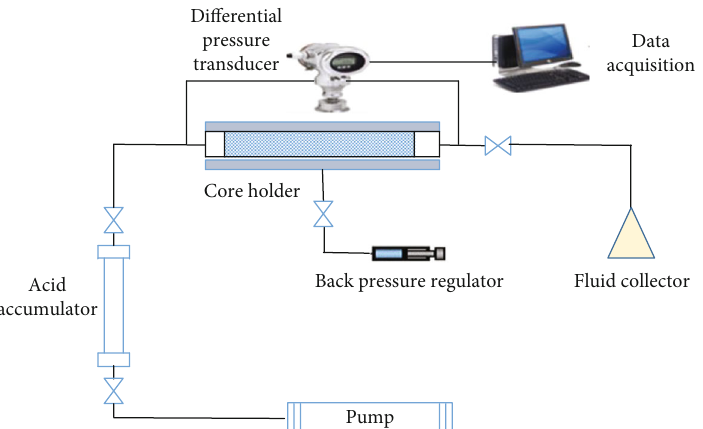
Figure 1: The scheme of the core fl ooding system.